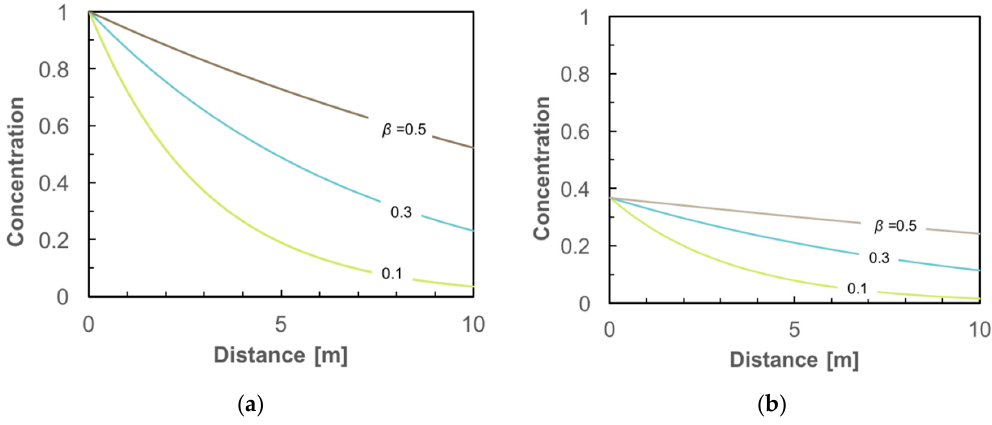
Figure 2. Effects of beta on spatial distribution at t = 1 with Λ = 0.5 and θ = 0.01. ( a ) Constant boundary source concentration and ( b ) time-dependent boundary source concentration.